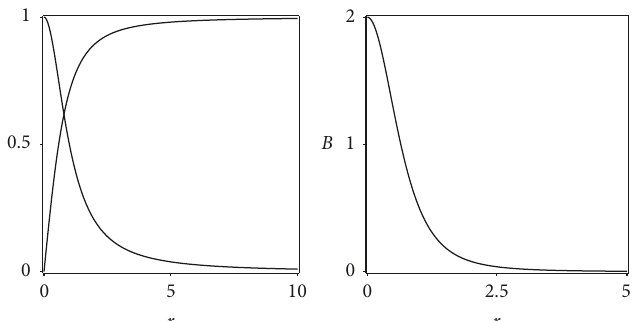
Figure 1: In the left panel, we display the solutions 𝑎(𝑟) (descending line) and 𝑔(𝑟) (ascending line) in (28). In the right panel, we show the magnetic field in (30).